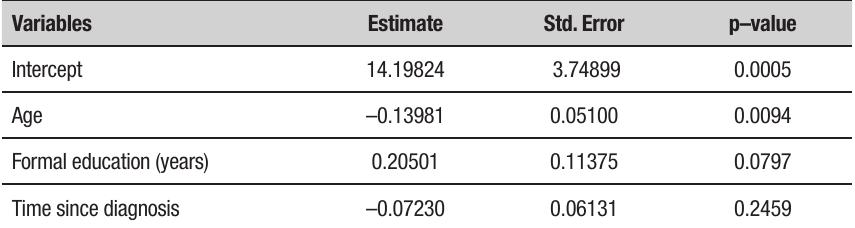
Table 3. Model of multiple linear regression for performance on BBRC–Edu (dependent variable – 5 min. recall memory).